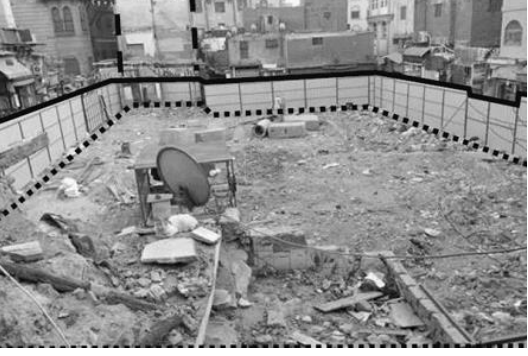
Figure 8. The black continuous line indicates the fence. The black dashed line indicates one of the attached buildings. The black dotted line indicates the ruins. (Source: Al-Mesryoon, 2019.